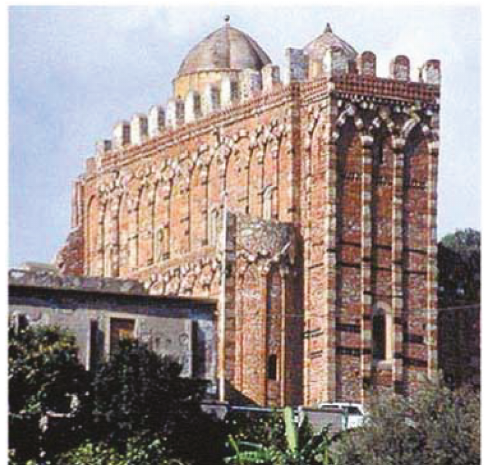
Figure 2: The Abbey of SS. Pietro e Paolo d ’